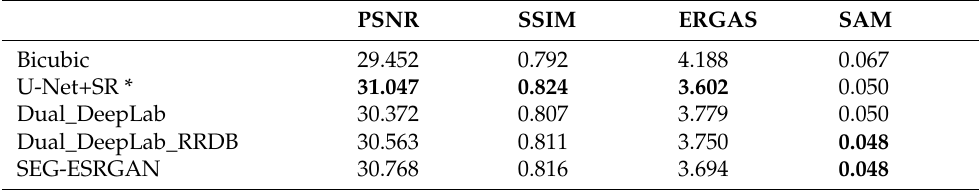
Table 6. Super-resolution metrics obtained with the test set of the dataset. Best values in bold.